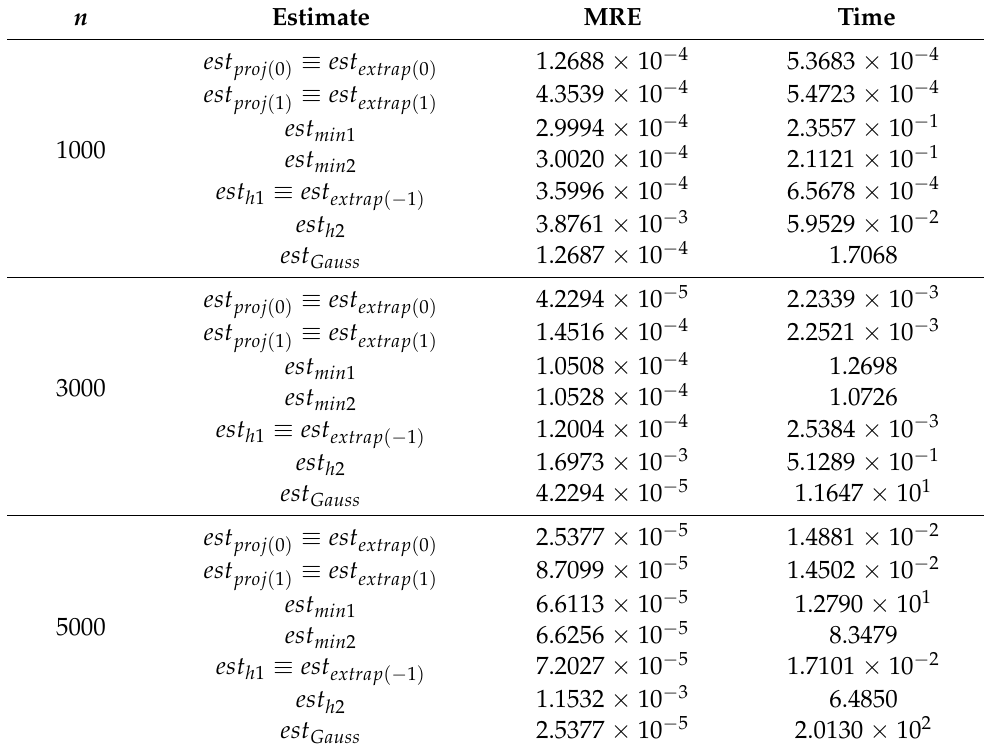
Table 4. Mean relative errors and execution times for estimating the diagonal of the covariance matrices of order n with ( α , β ) = ( 3,1 )